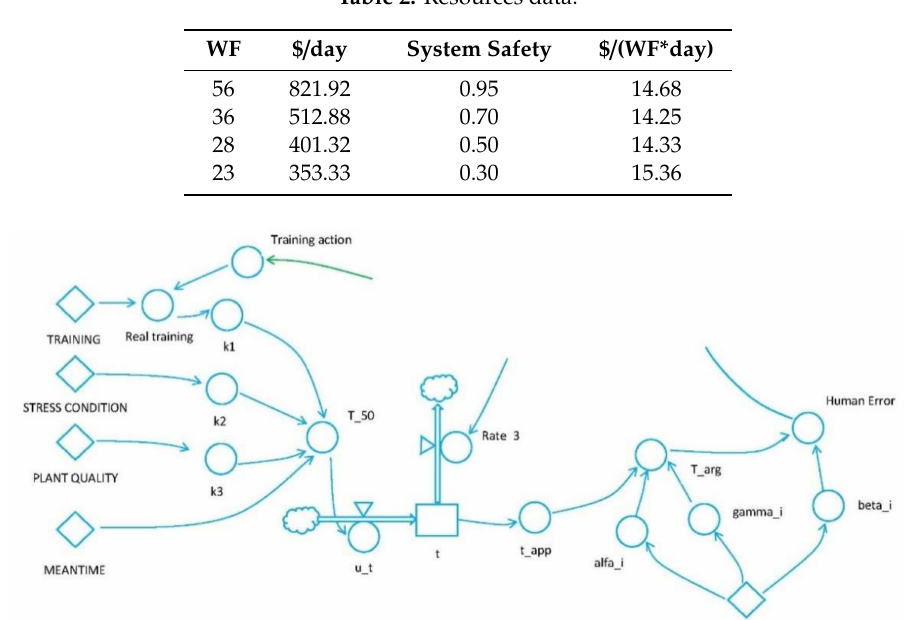
Figure 5. System dynamics diagram—human cognitive reliability (HCR) loop.